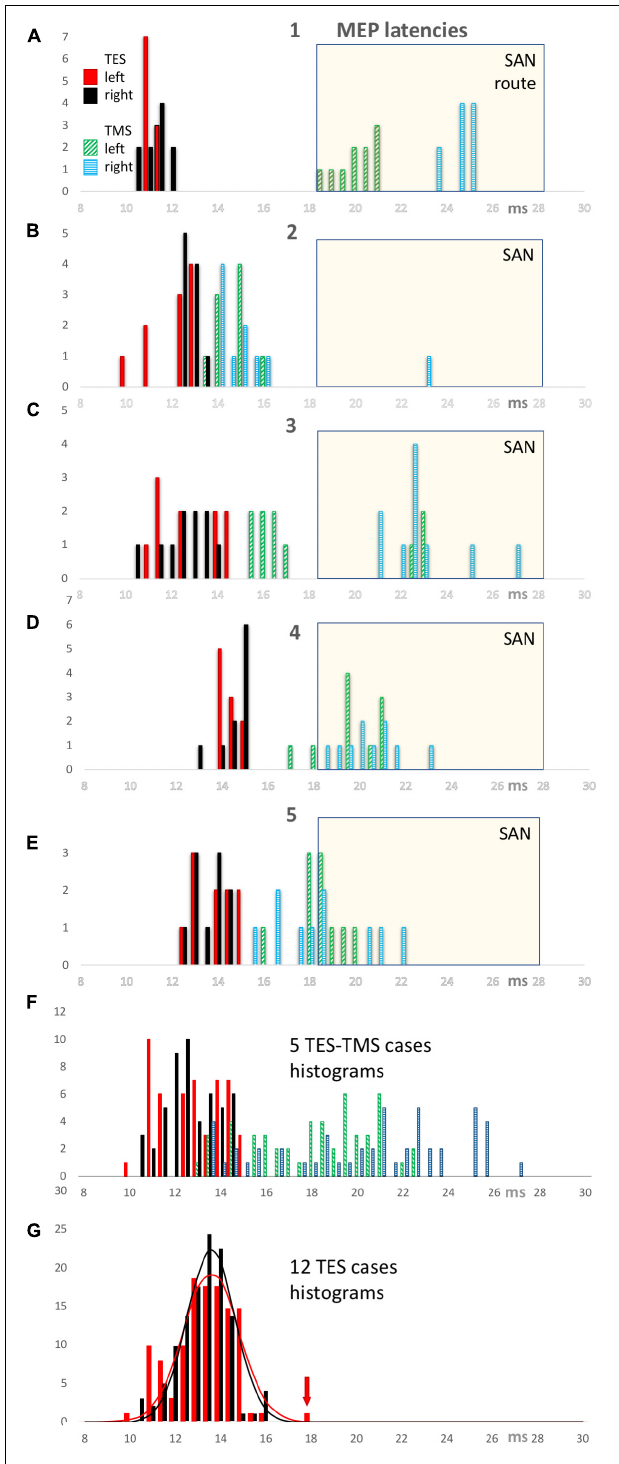
FIGURE 3 | TES and TMS MEP latency time histograms of individual cases 1 through 5 (panels A–E ) with a summarization of 5 cases in panel (F) . All TES latency times show a narrow distribution between 10 and 15 ms of which all observations belong to the direct motor conduction route. In contrast, the TMS latency histograms show a wide distribution between 13 and 27.1 ms